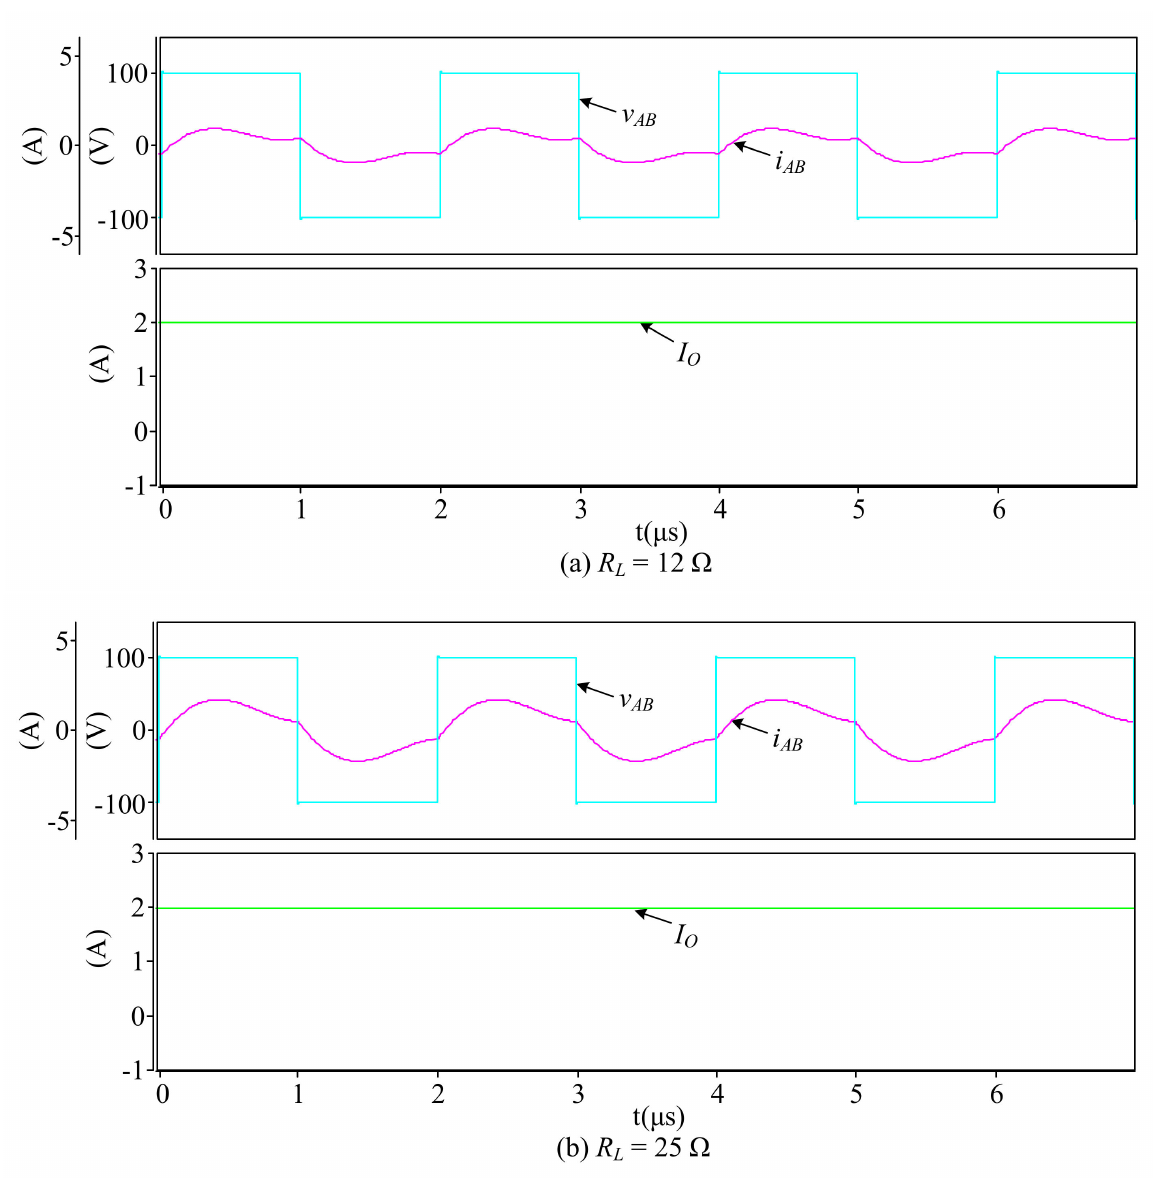
Figure 16. The waveforms of the L x − PS CPT circuit at CC mode. According to Figure 17, when the operating mode of the L x -PS CPT circuit is trans- ferred to CV mode, the output voltages at 25 Ω and 50 Ω are all 50 V. Similarly, the load-independent CV output is achieved and the input ZPA is